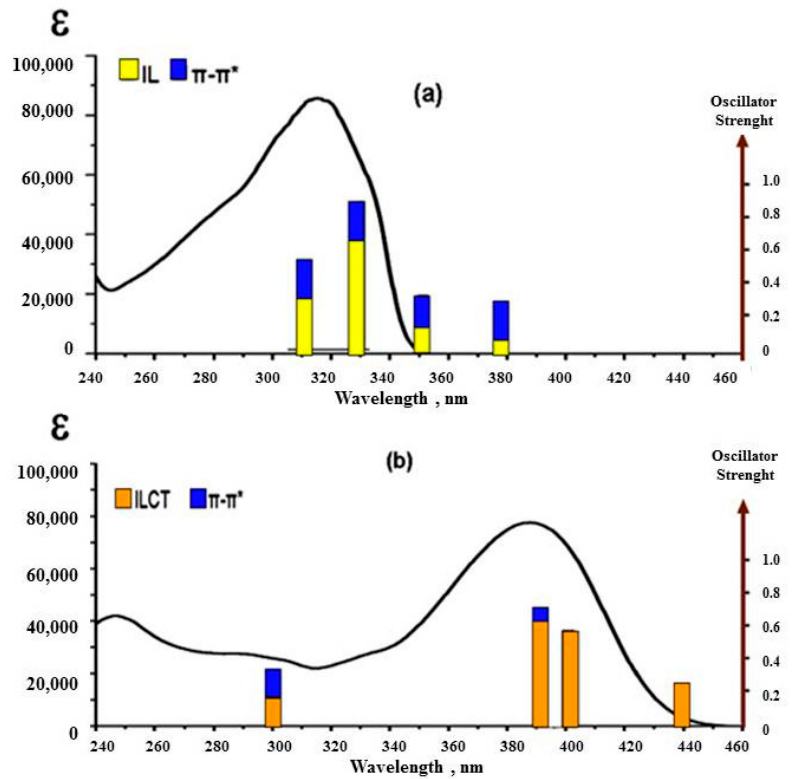
Figure 6. Experimental absorption spectra of ( a ) LH and ( b ) LN ligands in acetonitrile solvent. TTDFT-corresponding calculations are shown in bars.